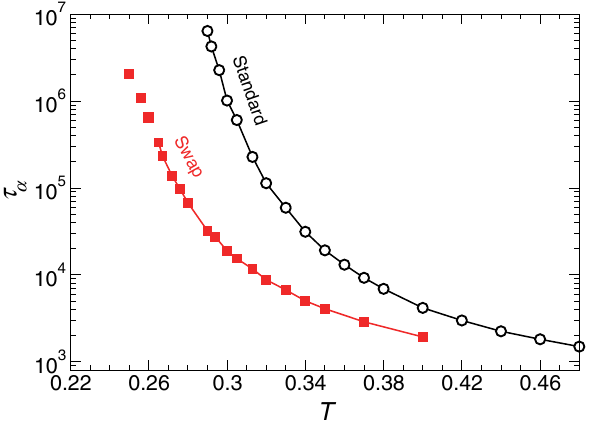
FIG. 6. Relaxation times τ α of standard (black empty points) and swap (red solid squares) simulations for the ternary mixture of soft repulsive spheres studied in Sec. III B. The speedup offered by the swap moves is obvious, but the system is unstable below T ¼ 0 . 26 ≈ 0 . 9 T where it demixes and crystallizes. MCT Disconnected squares are a rough estimate of τ α obtained using short simulations in the unstable region. Stable and equilibrated ¼ 0 . 288 , states can be accessed down to T ≈ 0 . 26 < T MCT extending the dynamic range by about 2 orders of magnitude as compared to standard